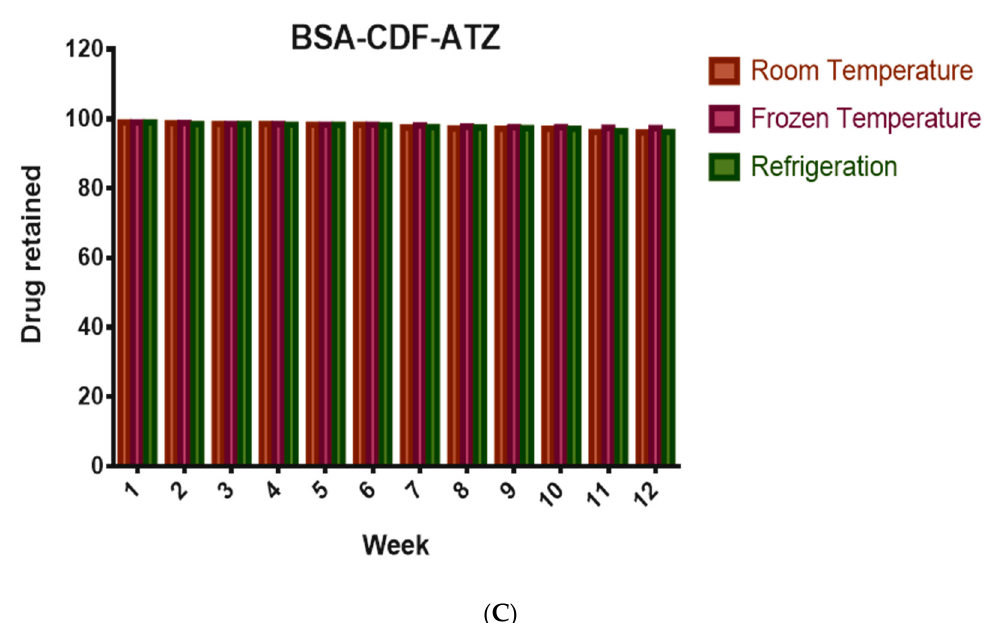
Figure 6. Stability studies after 3 months of storage at different conditions for BSA-CDF-ATZ in terms of ( A ) particle size; ( B ) polydispersity ratio (PDI); ( C ) percentage drug released. There was no